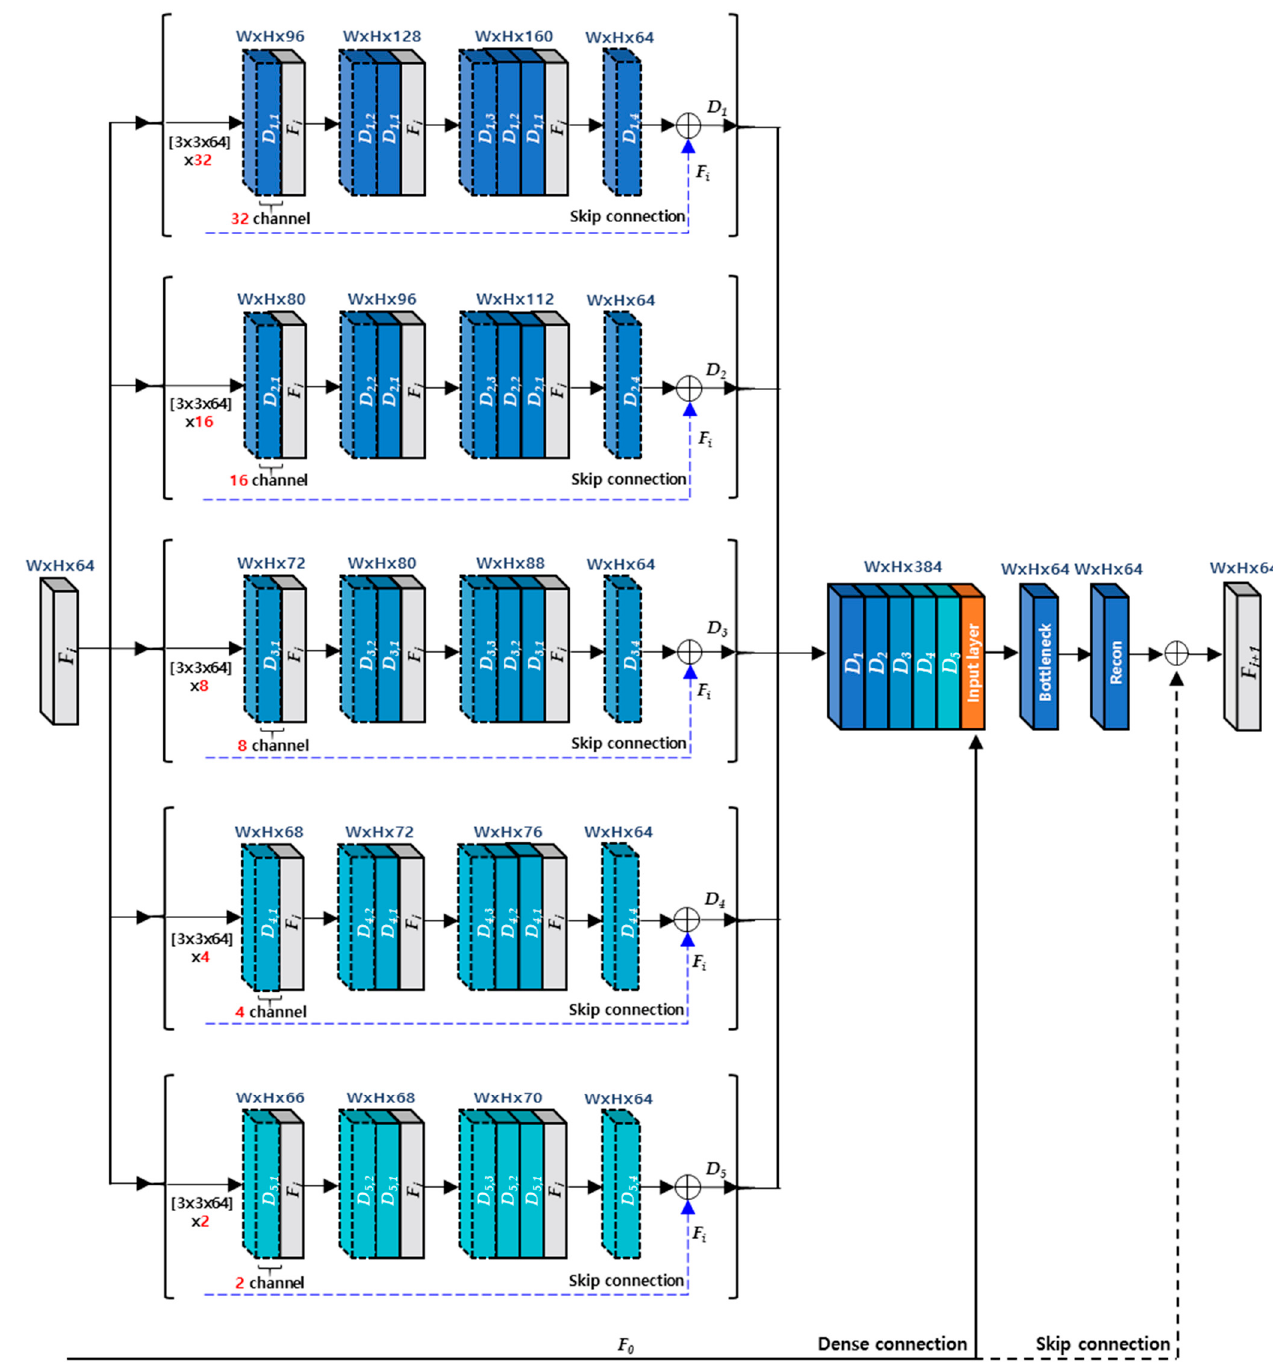
Figure 4. The architecture of a MCDB.